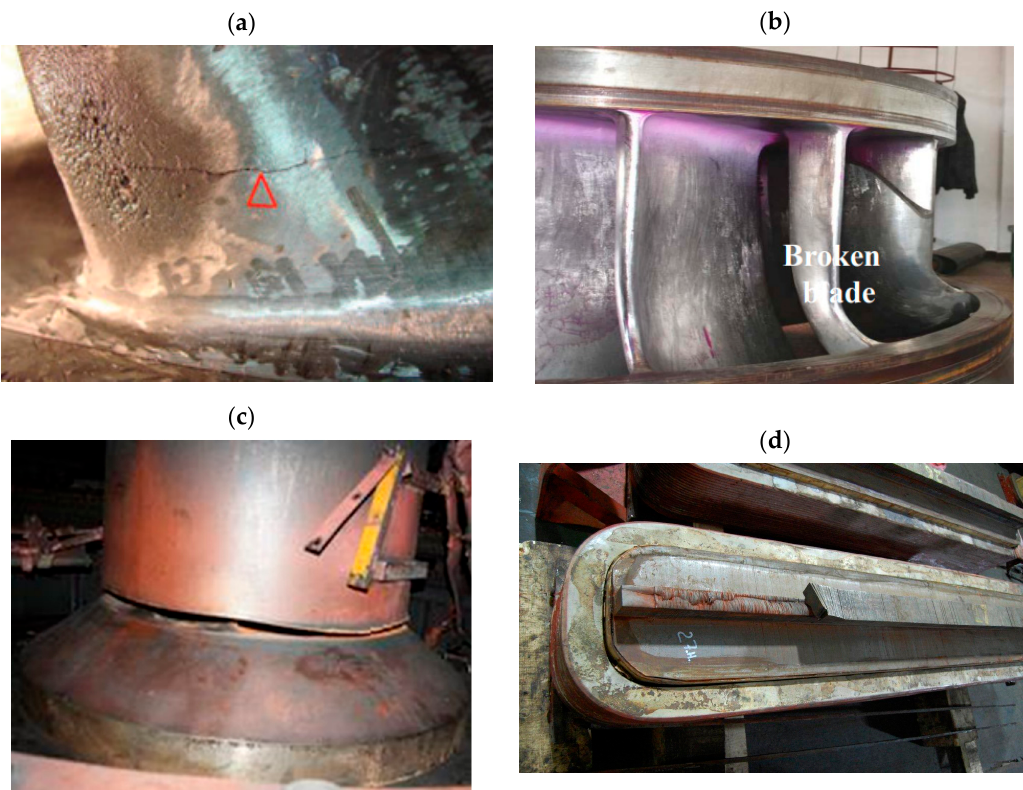
Figure 1. Examples of damage to hydraulic unit components: ( a ) crack on a trailing edge of a runner near the band [15]; ( b ) broken blade [17]; ( c ) broken shaft of the large hydraulic unit; ( d ) a hydro-generator pole with a broken dovetail.